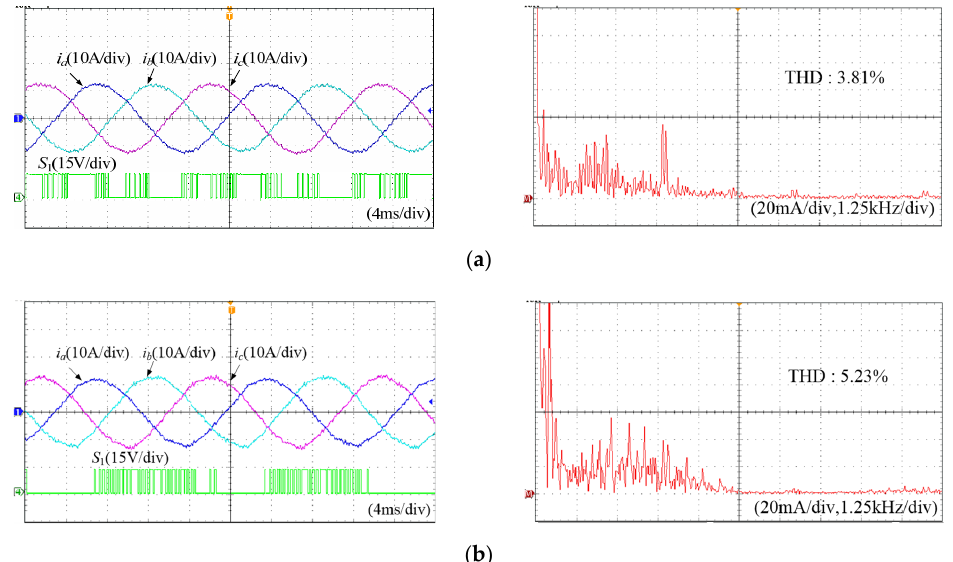
Figure 10. Experimental results of the three-phase output currents ( i a , i b , and i c ), the a -leg upper switch S 1 , and the frequency spectrum of the a -phase current with | I * | = 12 A. ( a ) the proposed method with T s = 250 μ s, and ( b ) the conventional method with T s = 125 μ s. THD: total harmonic distortion.